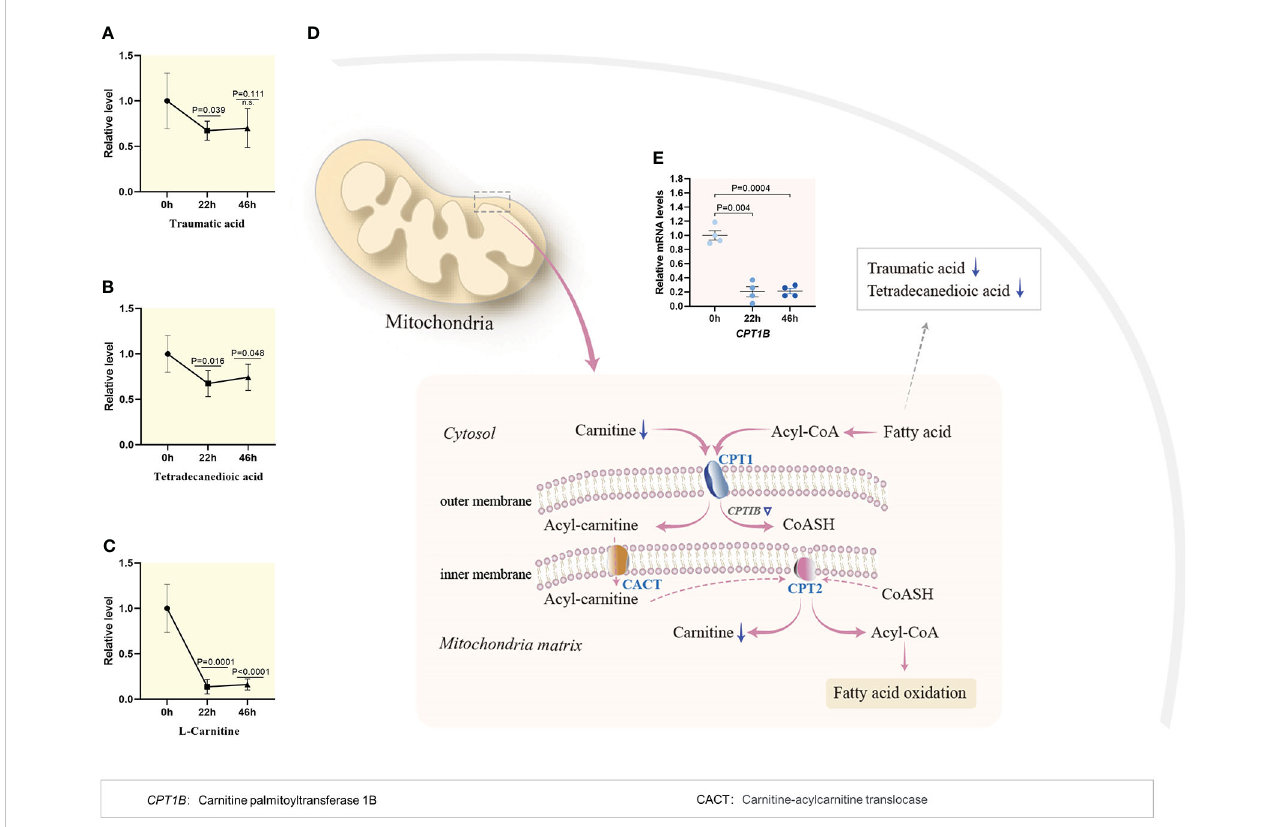
FIGURE 3 Reduced fatty acid beta oxidation during meiotic resumption. (A – C) Relative levels of metabolites related to fatty acid oxidation in oocytes at three time points. (D) Schematic diagram of carnitine shuttle system and utilization of fatty acid during porcine oocyte maturation, derived from metabolomics and transcriptomics. Metabolites decreased in oocytes during meiotic resumption are indicated by bold blue arrows. Differential expression genes decreased are indicated by blue triangles (E) Dynamic changes in the relative level of CPTIB during meiotic maturation. Error bars, SD. Student ’ s t test was used for statistical analysis in all panels, comparing to GV. n.s., not signi fi